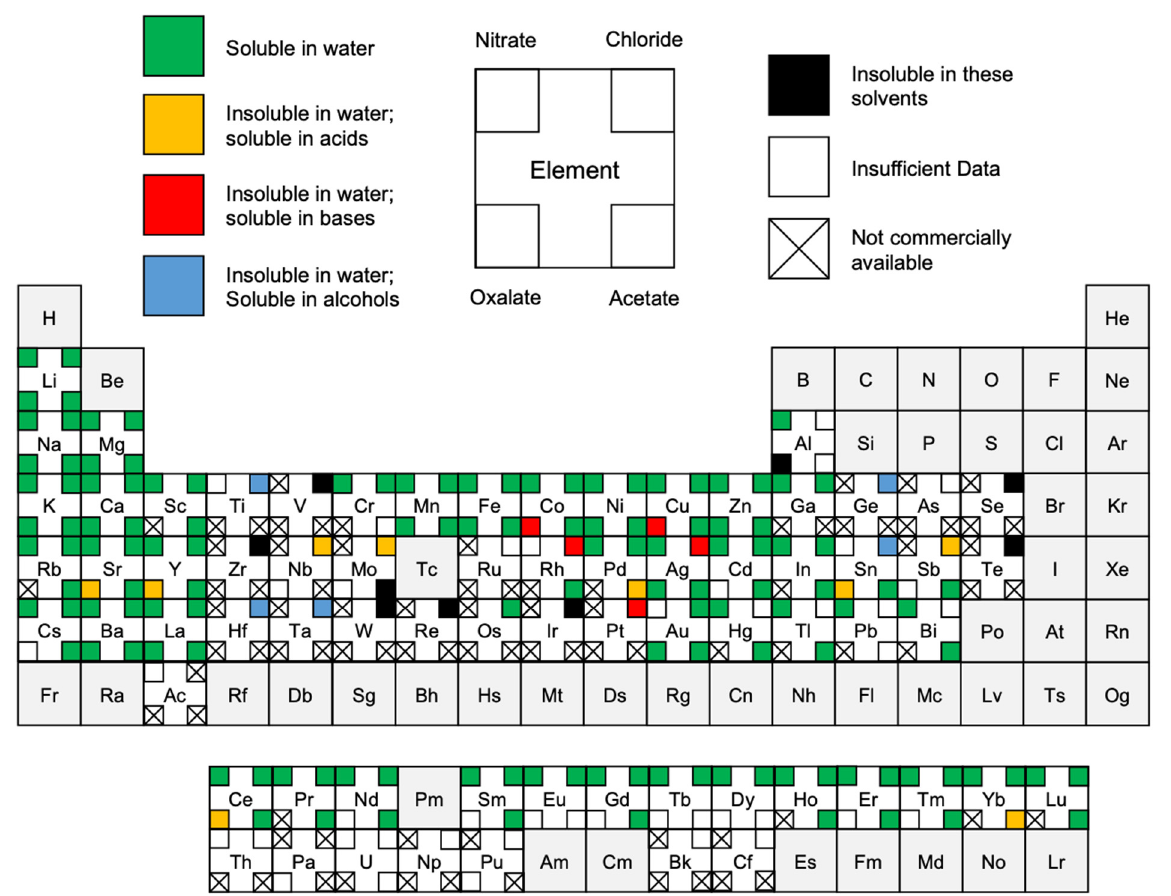
Figure 5. Periodic table of elements with solubility for available precursors. The four corners in each element contain precursor information for nitrates, chlorides, oxalates, and acetates. Greyed elements do not contain any commercially available precursors or the four investigated. A square with an “x” shows that that specific precursor is not available. The color of the square in each precursor’s corner depicts its solubility, be it in water (green), acids (yellow), bases (red), alcohols (blue), or none of these solvents (black). Insufficient solubility data is shown as white.